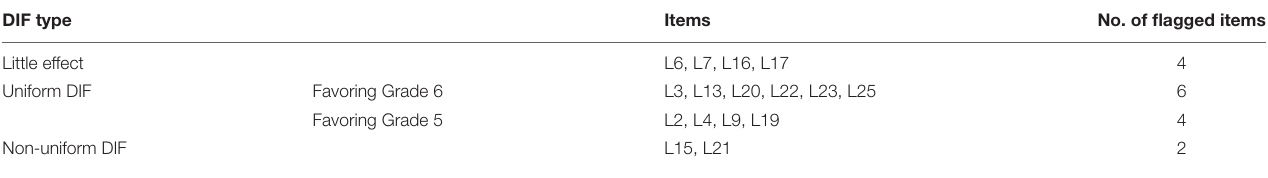
TABLE 4 | Types of DIF